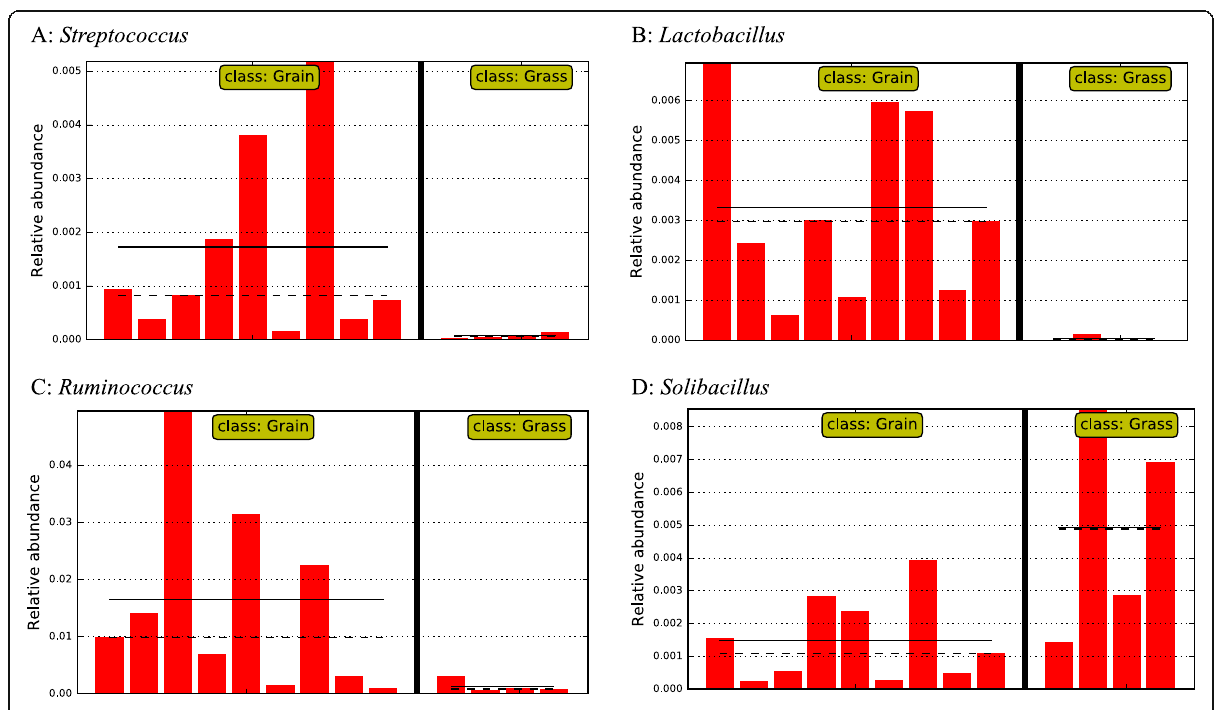
Fig. 6 Selected genera displaying significant differences in relative abundance in jejunal bacterial communities between grass-fed and grain-fed cattle.